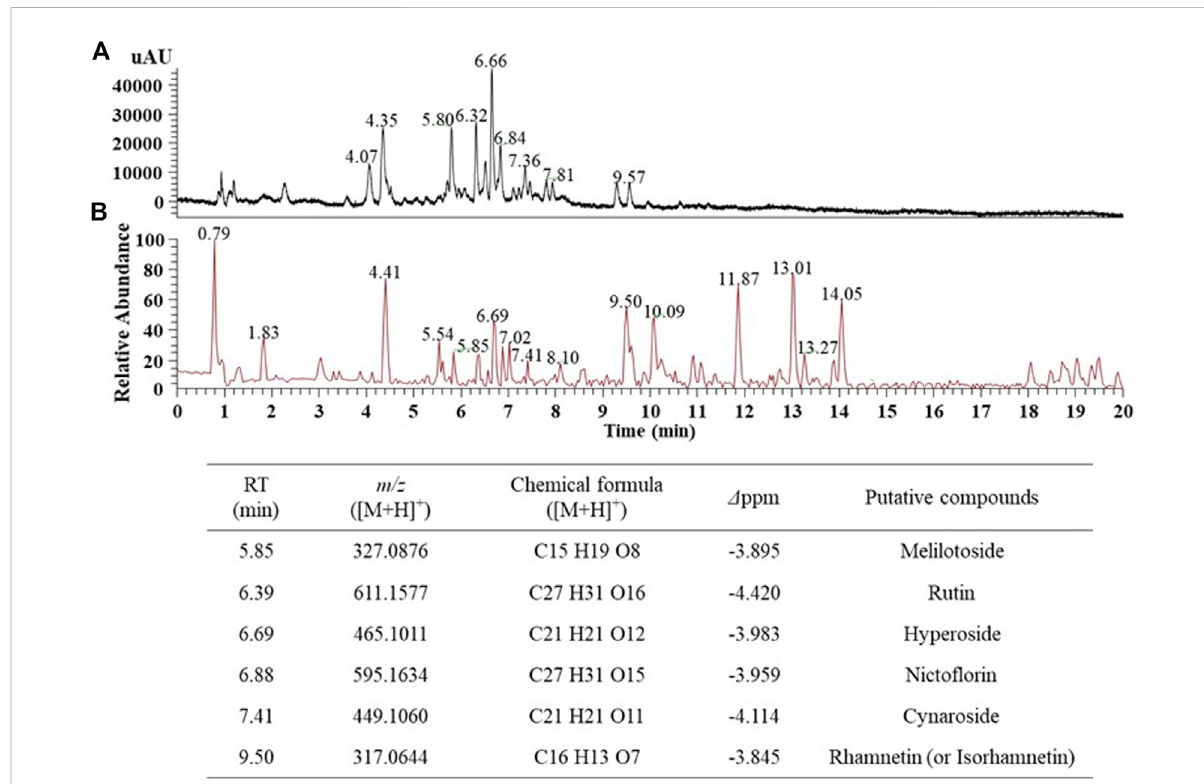
FIGURE 1 UPLC-MS chromatogram of the 70% ethanol extract of E. japonicum (EJ). (A) Photo diode array (PDA) chromatogram, (B) Total ion chromatogram (TIC), and putative identi fi cation of six major phytochemicals in EJ as listed in Table. EJ (10 mg/ml) was introduced into the UPLC system, and separation and detection conditions were described in Supplementary Table